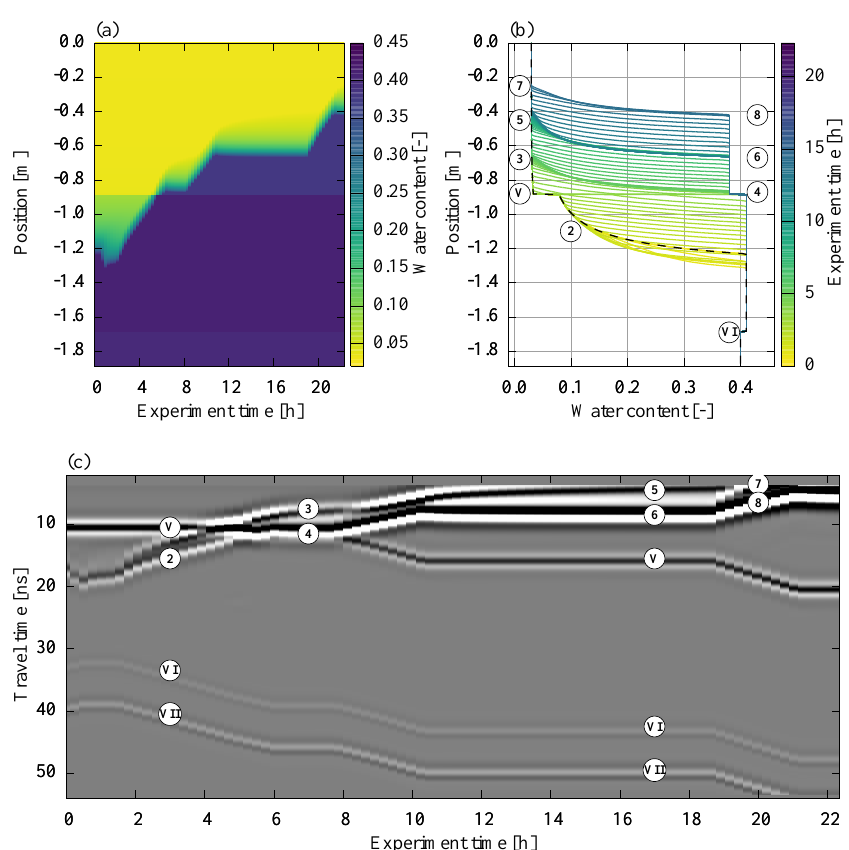
Figure 9. The true synthetic data are simulated with hydraulic parameters that represent coarse-textured sandy soils (Table 2). (a) and (b) show different representations of the simulated water content. In (b) the initial water content distribution is marked with a black dashed line. (c) shows the simulation of the GPR signal. The imbibition leads to a characteristic transition zone reflection (marker (2)). The temporal evolution of this reflection is sensitive to the initial water content distribution, the soil water characteristic, and the hydraulic conductivity function. The data shown are processed according to Sect. 2.3 except for the normalization. In contrast to the data that are evaluated, the shown radargram is normalized to the maximum absolute amplitude of all traces, facilitating the visual comparison of the traces. The markers are defined in Fig.